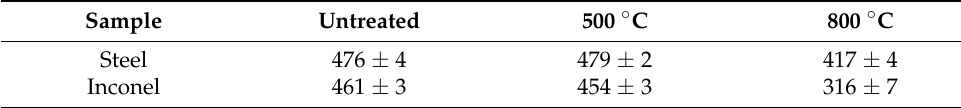
Figure 4. Critical load as a function of temperature of the thermal treatment.